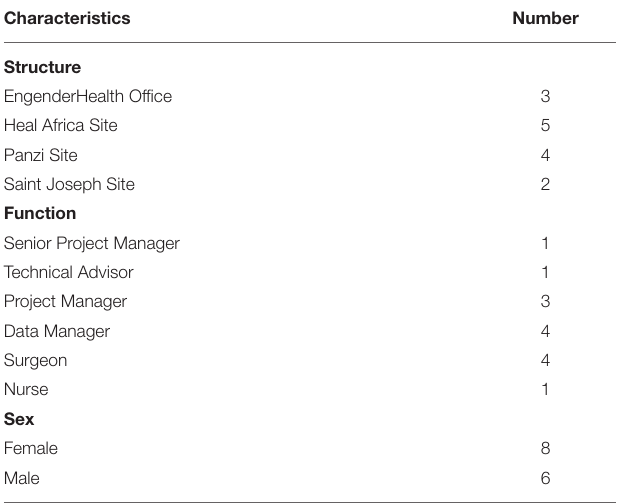
TABLE 2 | Characteristics of participants in the qualitative study ( N =